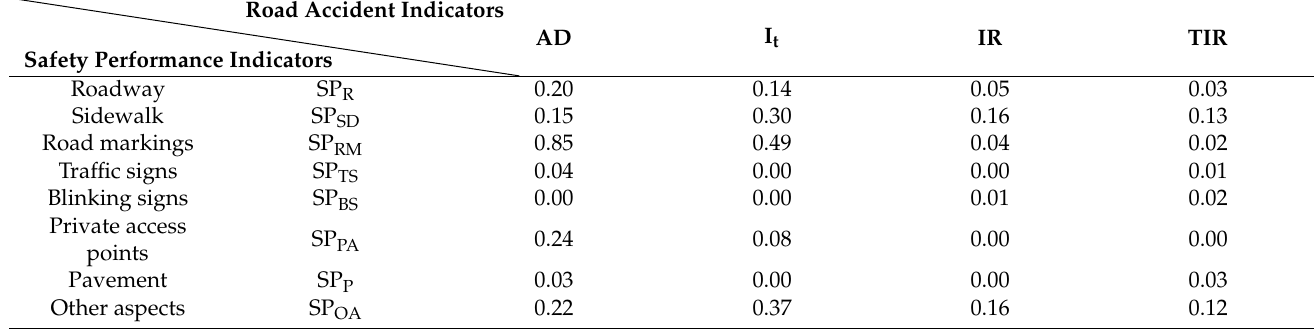
Table 5. R 2 values for the urban environment.